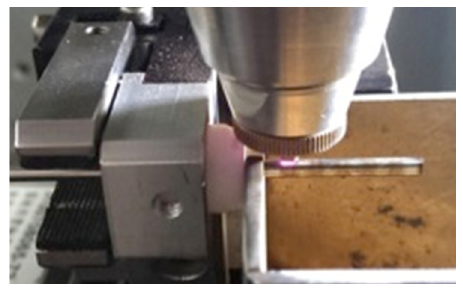
Figure 6. Coded design pattern of the spherical occlusion device cut into a 2.0 mm hypotube by laser.